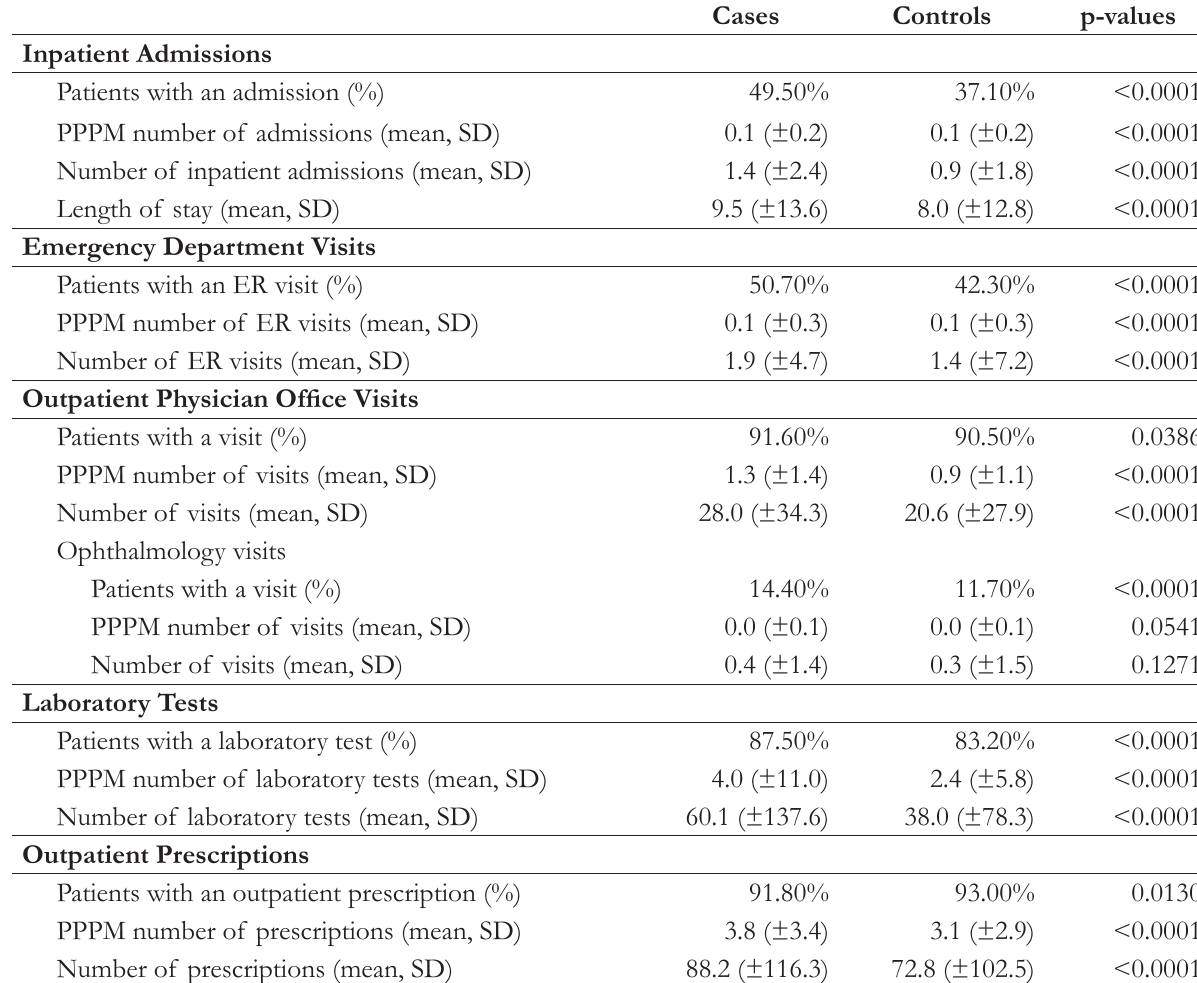
Table 4. Healthcare Utilization of Aspergillosis Cases and Propensity-Score Matched Controls Cases Controls